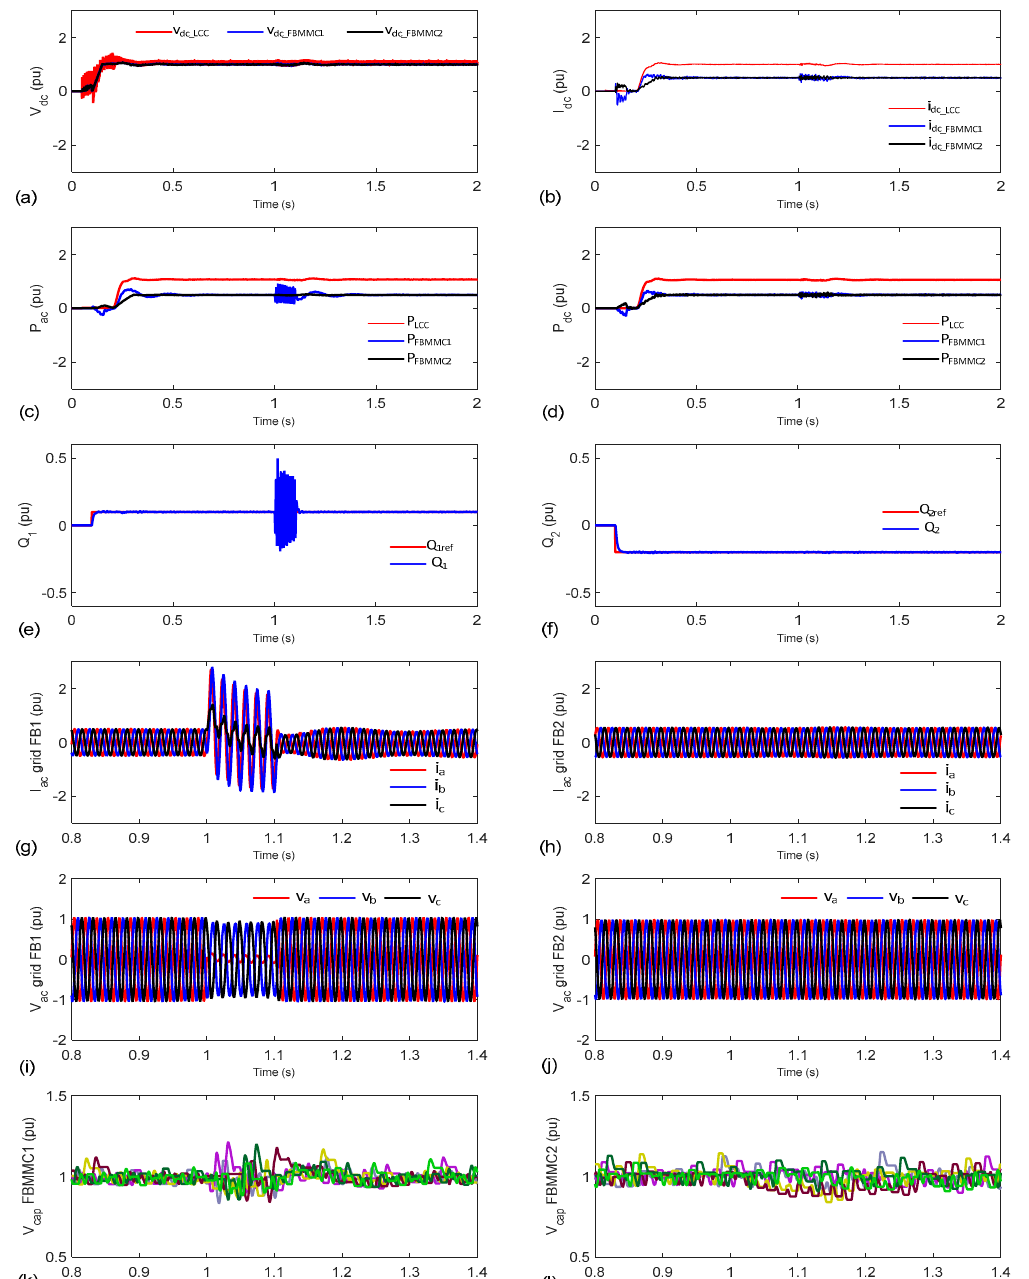
Figure 12. H 2 VDC system behavior during a single-phase fault at t = 1 s for 0.1 s in phase a of